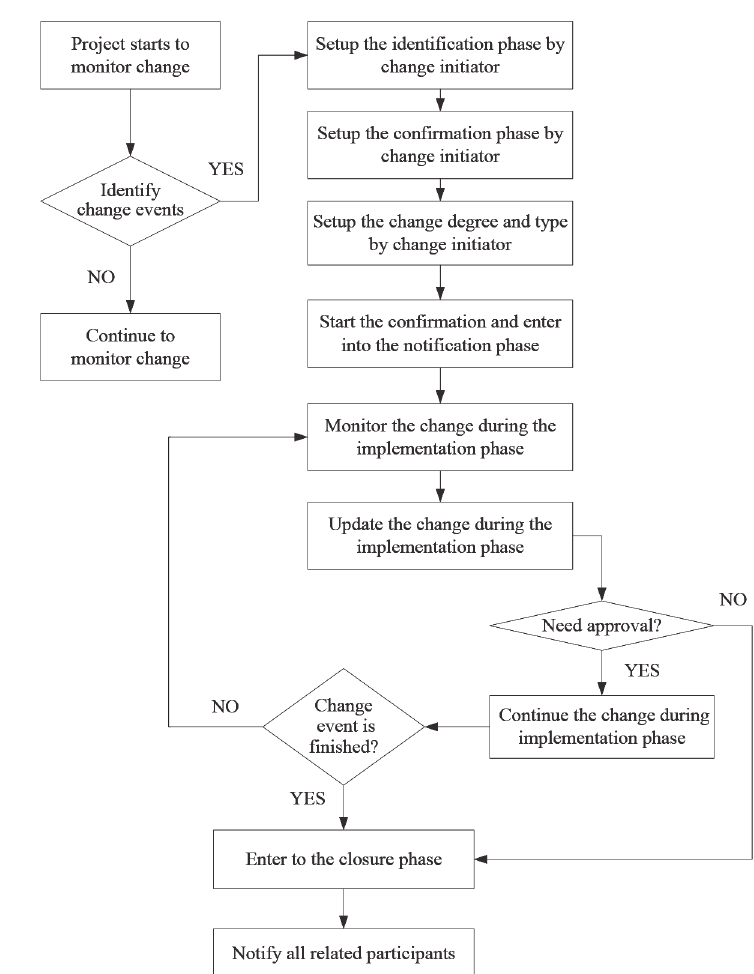
Fig. 3. Steps of monitoring changes in the proposed system